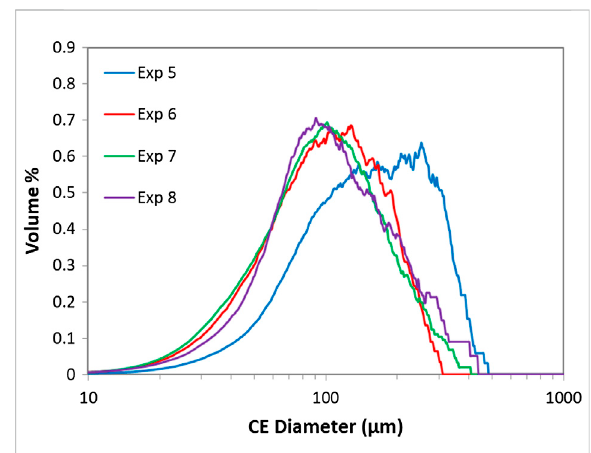
FIGURE 11 Volume weighted circle equivalent diameter distributions from Morphologi G3 for the X-mixer and MSMPR cascade